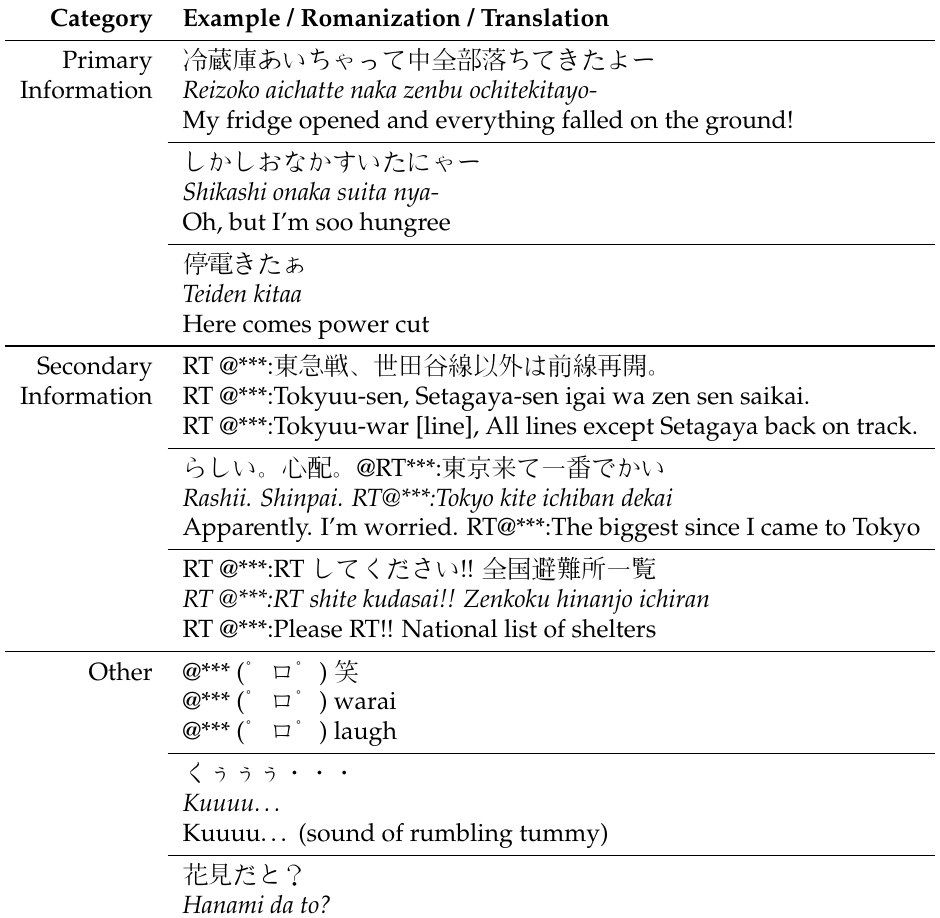
Table 1. Examples of each type of information found in the Earthquake